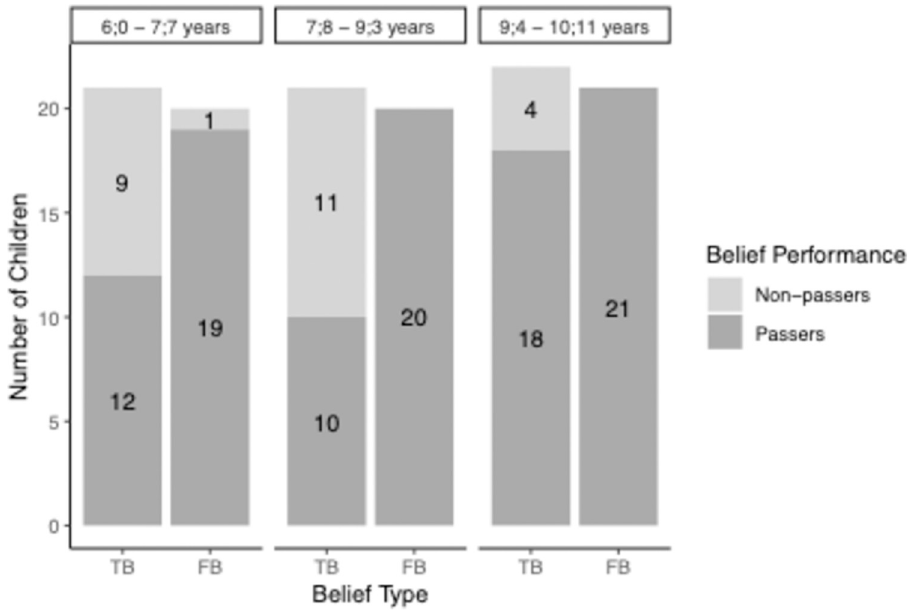
Fig 6. Children’s performance in the standard change-of-location task as a function of belief type and age in Study 3. Note . Sample size of the groups vary as only children were included who answered the respective control questions